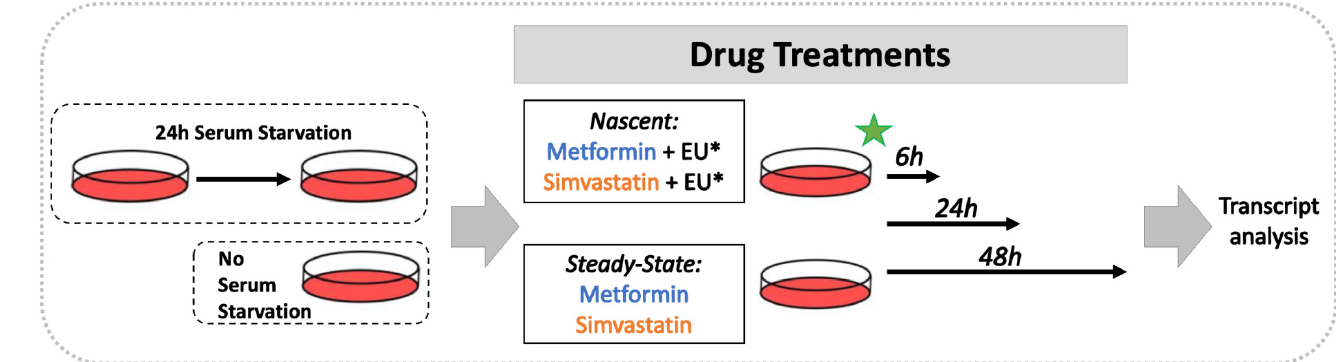
Figure 1. Schematic representation of Daoy cell treatment with metformin and simvastatin.